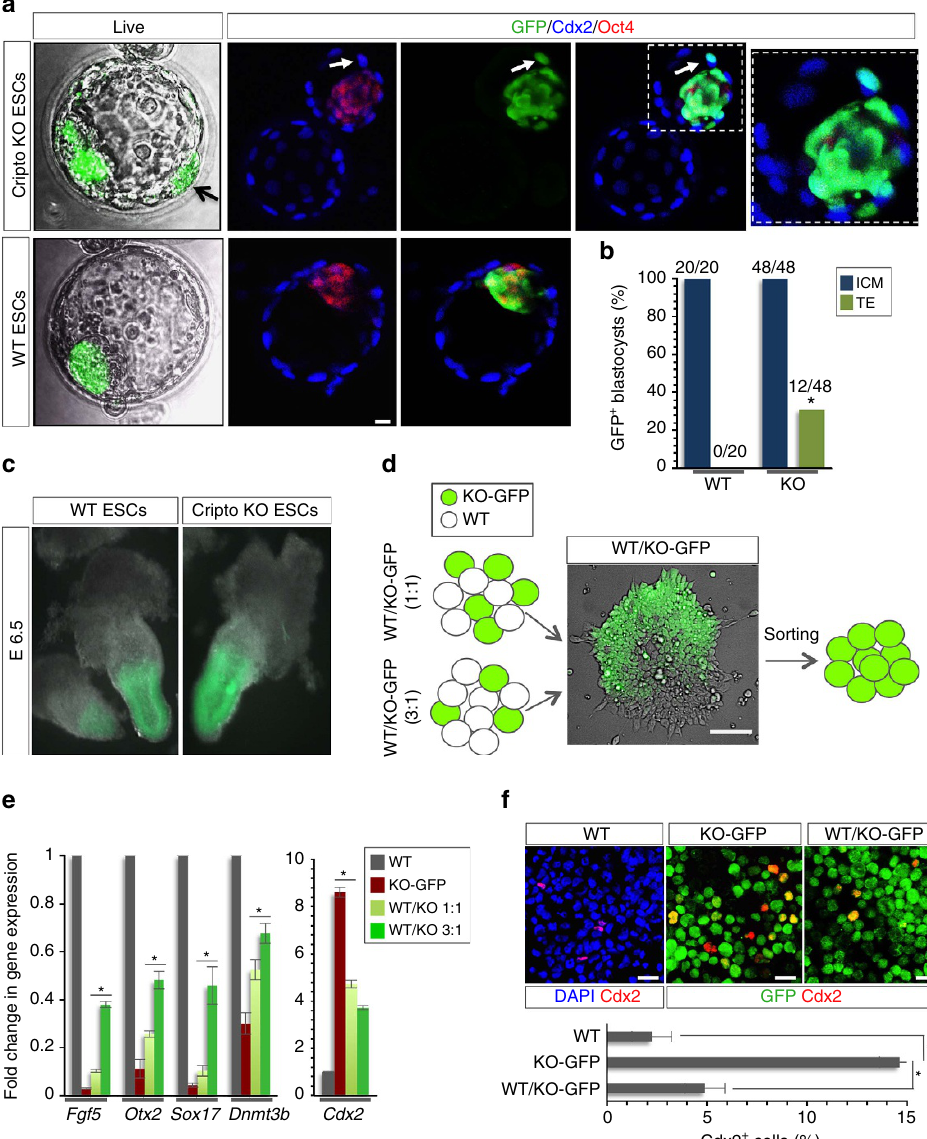
Figure 6 | Cripto depletion attenuates ESC differentiation potential towards embryonic lineages in vivo. ( a ) Chimeric blastocysts from GFP-labelled WT and Cripto KO ESCs by live confocal microscopy imaging (original magnification (cid:3) 20) and whole-mount immunostaining against GFP, Cdx2 and Oct4; arrow marks GFP þ TE cells (scale bar, 10 m m). ( b ) Frequency of blastocysts with GFP þ ICM and TE cells from WT (blastocysts n ¼ 20) and Cripto KO chimeric embryos from GFP-labelled WTand Cripto KO ESCs injected into morula and dissected at E6.5. ( d ) Schematic representation of the experimental procedure and representative picture of co-culture WT and Cripto KO colony. ( e ) Effect of F/A on the expression of selected markers in WT, Cripto KO ESCs and WT ESCs mixed at 1:1 and 3:1 ratios with Cripto KO-GFP ESCs. Relative RNA level was normalized to Gapdh ; data are mean ± s.e.m. ( n ¼ 3; P* o 0.01). ( f ) Representative pictures of 4,6-diamidino-2-phenylindole (DAPI)/Cdx2 and GFP/Cdx2 double immunostaining (upper panels; scale bar, 75 m m) and quantification of Cdx2 þ cells (bottom panel; B 100 cells per condition) of F/A WT, Cripto KO and WT/Cripto KO cytospinned cells mixed at 3:1 ratio. Data are mean ± s.e.m. ( n ¼ 3; P* o 0.01).